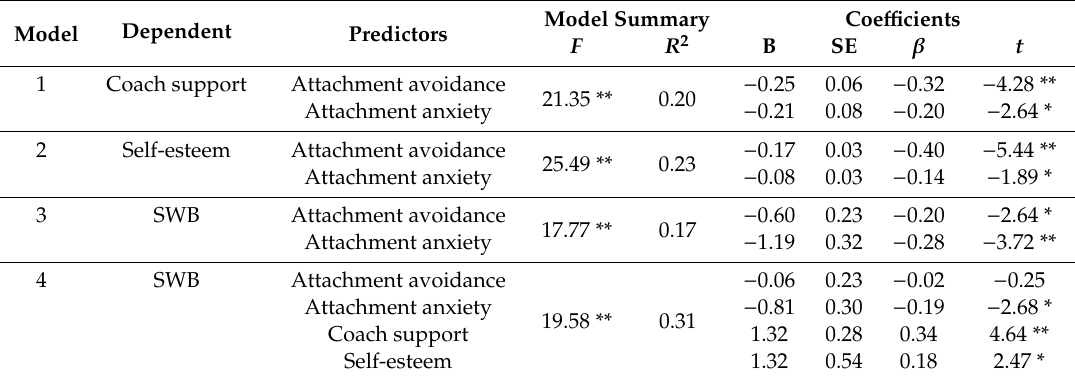
Table 2. Regression analysis ( n =